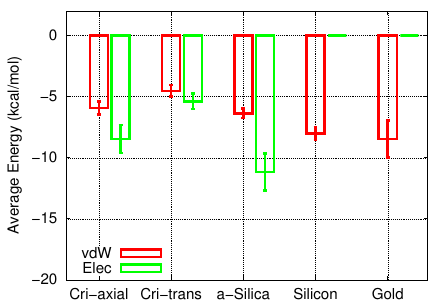
Figure 5. Average electrostatic (Elec) and vdW energies between the cisplatin molecule and the pore surface during the 3-ns diffusion process as a function of pore material. Error bars were obtained from the fluctuations of the energies along the